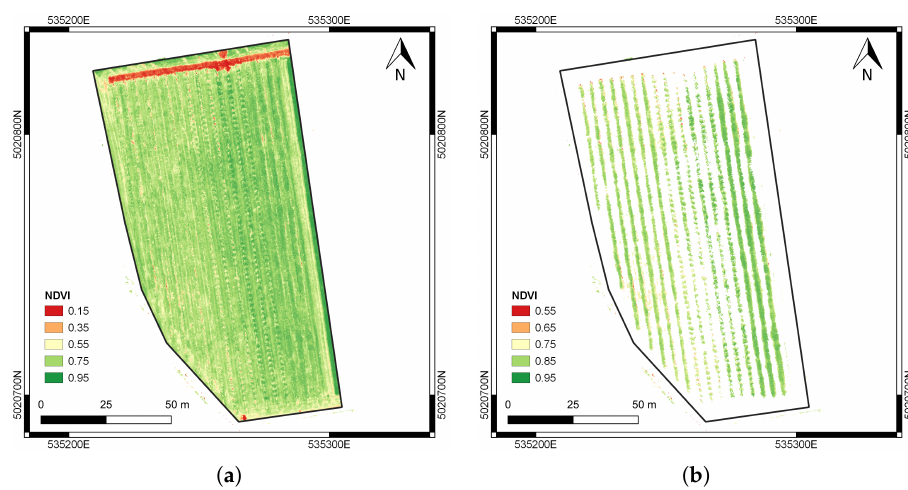
Figure 12. Pear orchard site: NDVI map before ( a ) and after ( b ) the crop rows’ extraction.